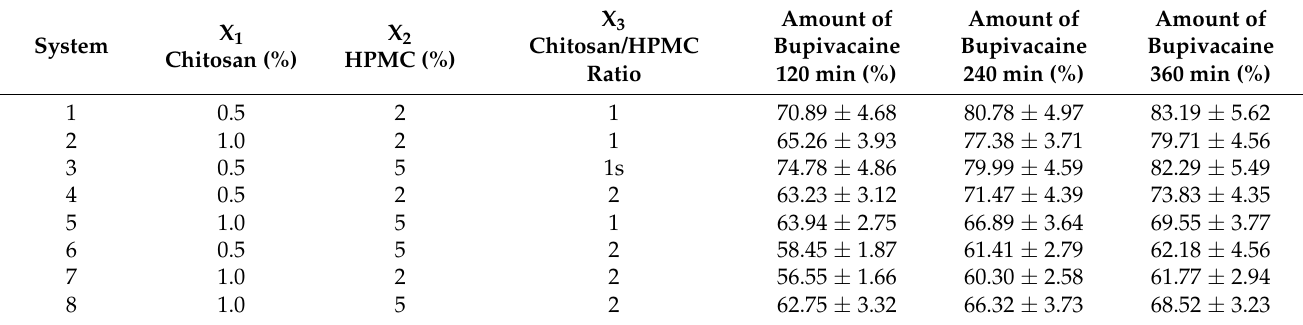
Figure 5. Variation of viscosity as a function of the shear rate for the designed systems. As can be seen from Table 6, the highest viscosity values recorded at 20 rpm were observed in colloidal systems 5 (70.36 cP), 7 (62.32 cP) and 8 (119.87 cP), and they also had high concentrations of polymers in the composition. 120 min, 240 min and 360 min, along with the 3 formulation variables (X1: concentration percentage of chitosan; X2: concentration percentage of HPMC E 5 LV; and X3: polymer ratio for chitosan/HPMC E 5 LV). The colloidal gelling in situ systems released more than 56% of the drug substance after 2 h, and after 6 h, they released between 61.7% (system 7) and 83.1% (system 1) of the drug substance. Table 7. Cumulative percentage of bupivacaine hydrochloride released at predetermined time intervals (120 min, 240 min and 360